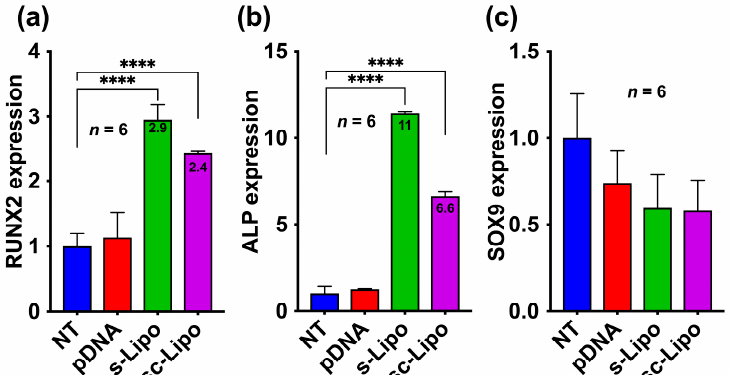
Figure 4. Quantitative RT-PCR of hMSCs transfected with BMP-2 plasmid followed by encapsulation in HA hydrogels after 7-days. ( a ) Expression profile of early osteogenic markers, RUNX2, and ( b ) ALP after 7-days of the experiment. ( c ) Expression profile of chondrogenic markers after 7-days of the experiment. Mean values ± SD of 2 independent experiments done in triplicates ( n = 6) are shown. TBP was employed as an internal control to normalize BMP-2 mRNA expression. Gene expression values are stated as fold change relative to controls. Statistical analysis was performed using one-way ANOVA with Bonferroni’s multiple comparison corrections (**** p < 0.00001). The abbreviation NT = non-treated cells; pDNA = plasmid DNA alone; s-Lipo = Lipofectamine TM 2000 assisted transfection of cells in suspension followed by encapsulation in HA-hydrogel; sc-Lipo = Lipofectamine TM 2000 assisted transfection of cells in suspension followed by centrifugation and subsequent encapsulation in HA-hydrogel.